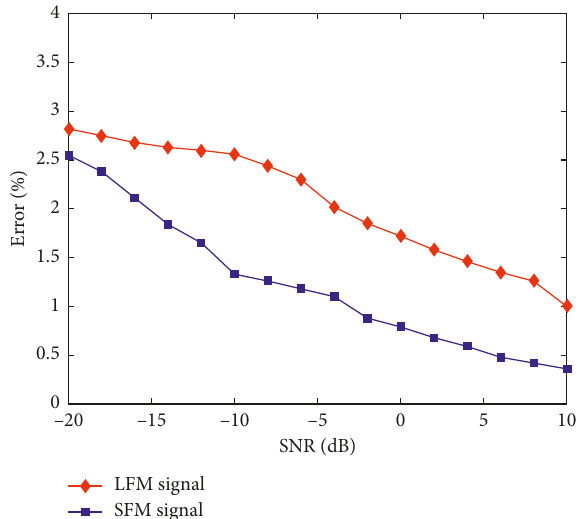
Figure 17: Instantaneous frequency estimation errors based on the proposed method under different SNR.